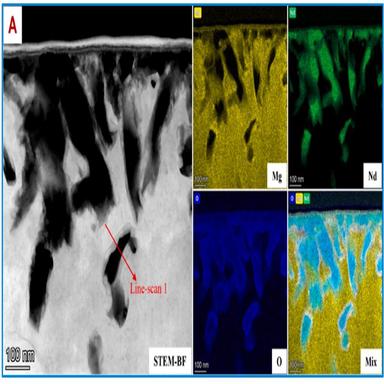
(a) STEM-BF image and corresponding EDS elemental distribution maps of the region occupied by Mg12Nd precipitate after oxidation for 1 h; (b) enlarged STEM-BF image and corresponding EDS elemental distribution maps of Region A in; (c) EDS line-scan 1 showing the elemental distribution across the oxide precipitate in (b); (d) HRTEM images of Mg matrix, MgO, and Nd2O3.